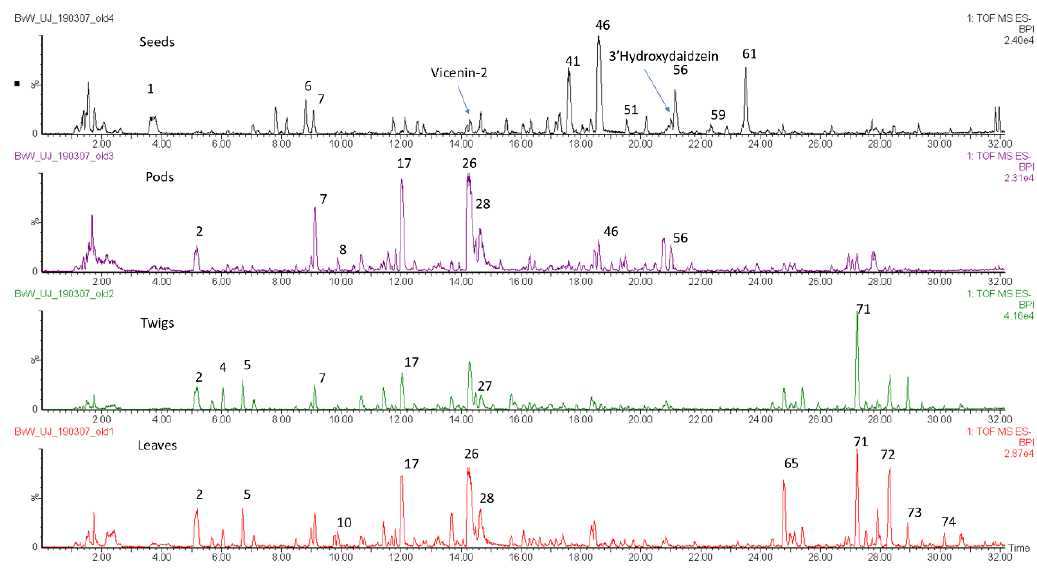
Figure 8. Total ion chromatograms of different plant parts of Cyclopia aurescens Kies, showing the seed extract on top with low levels of mangiferin and isomangiferin (compounds 26 and 28) and large peaks for compounds 46 (naringenin- O -hexoside isomer 3), 56 (butein) and 61 (butein-hexoside isomer 2).